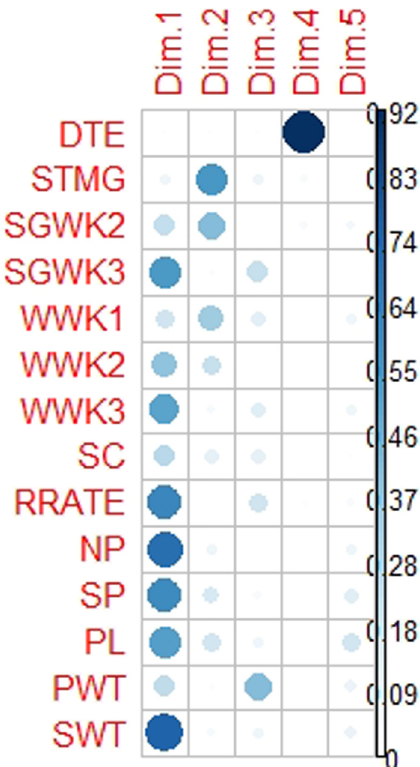
Figure 7: The contribution of various variables to DIM 1 to DIM 5. SGK1 – stem greenness in week 1; SGWK2 – stem greenness in week